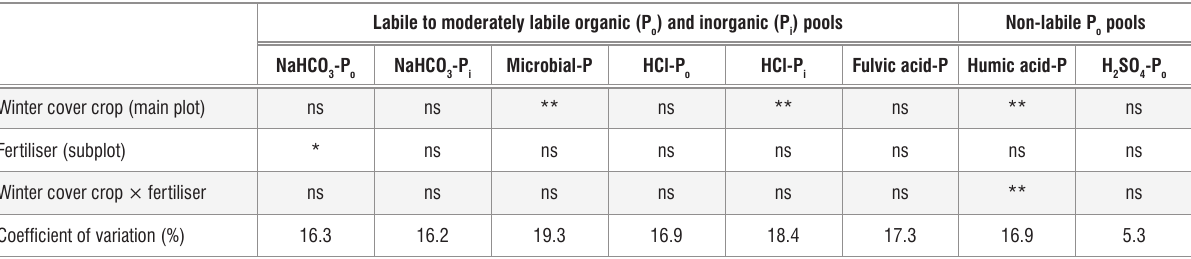
Labile to moderately labile organic (P